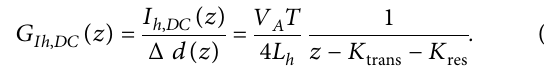
Figure 6: Simplified four terminal device of H voltage measuring method M Current measuring method M conventional